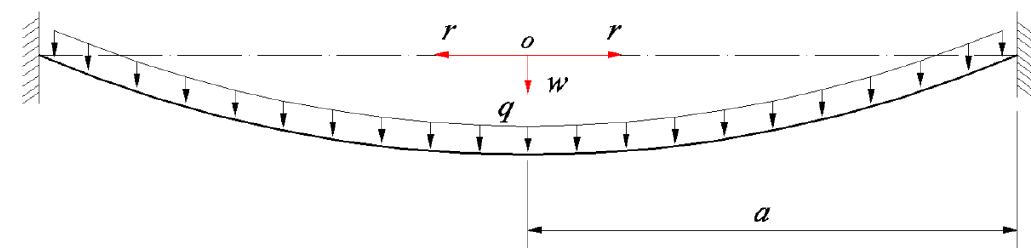
Figure 1. Sketch of the circular membrane under transverse loads q .